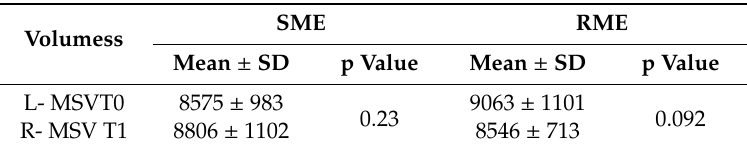
Table 2. Descriptive statistics (mean ± standard deviation) and independent t -test comparing right and left side of maxillary sinus volume before expansion treatment in each group.